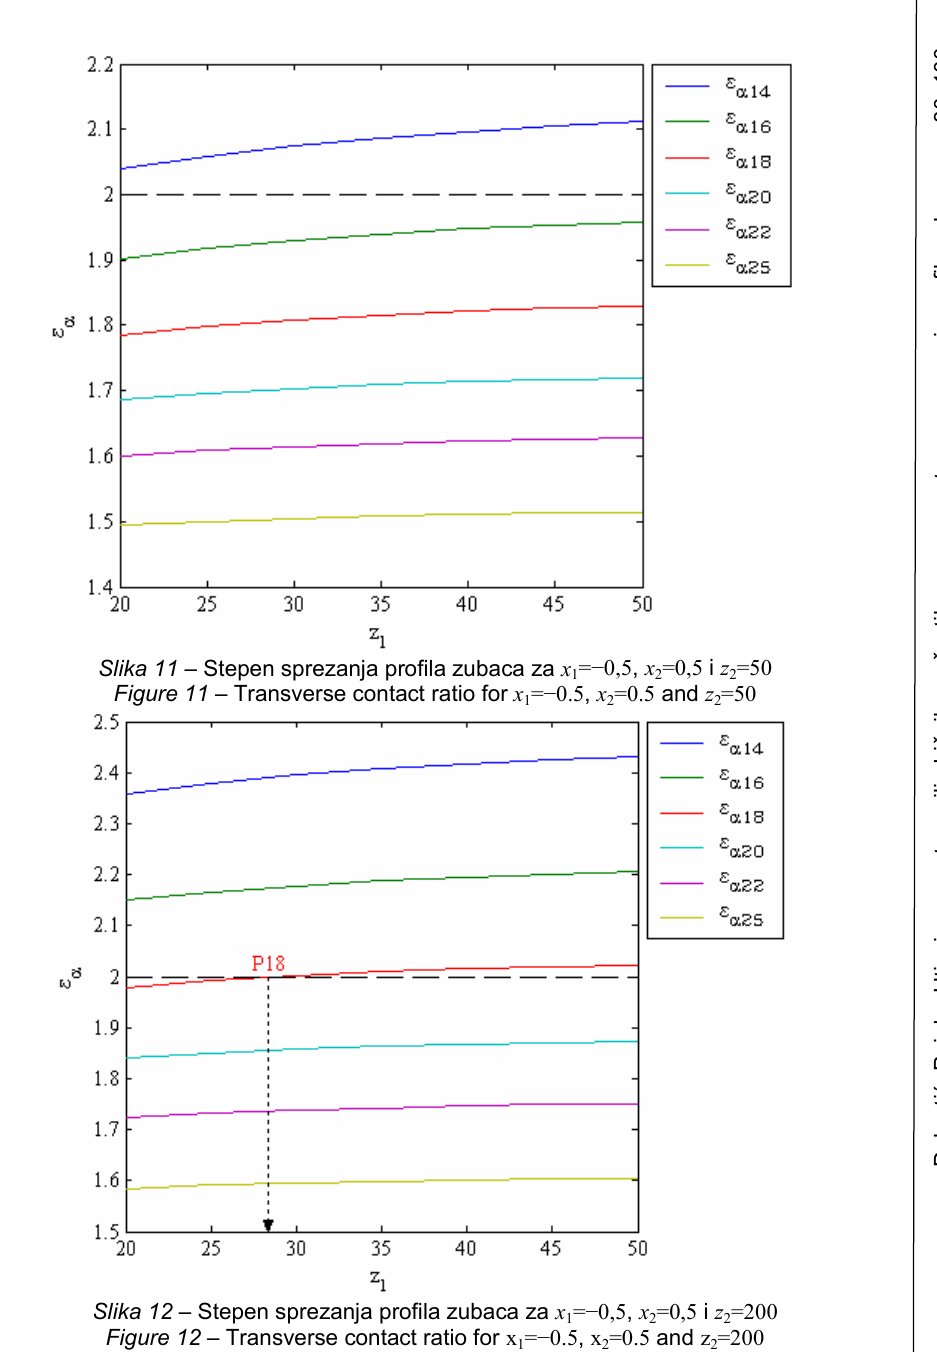
Figure 12 – Transverse contact ratio for x 1 = − 0.5 , x 2 =0.5 and z 2